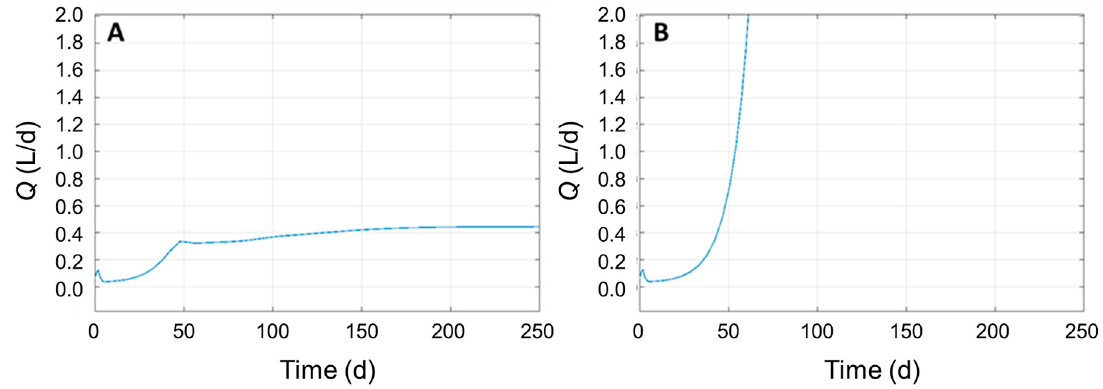
Figure 2. Simulation of biomethane yield ( Q ) during time using parameters from [11] (panel A ) and with Y glu/X 1 = 0 (panel B ).